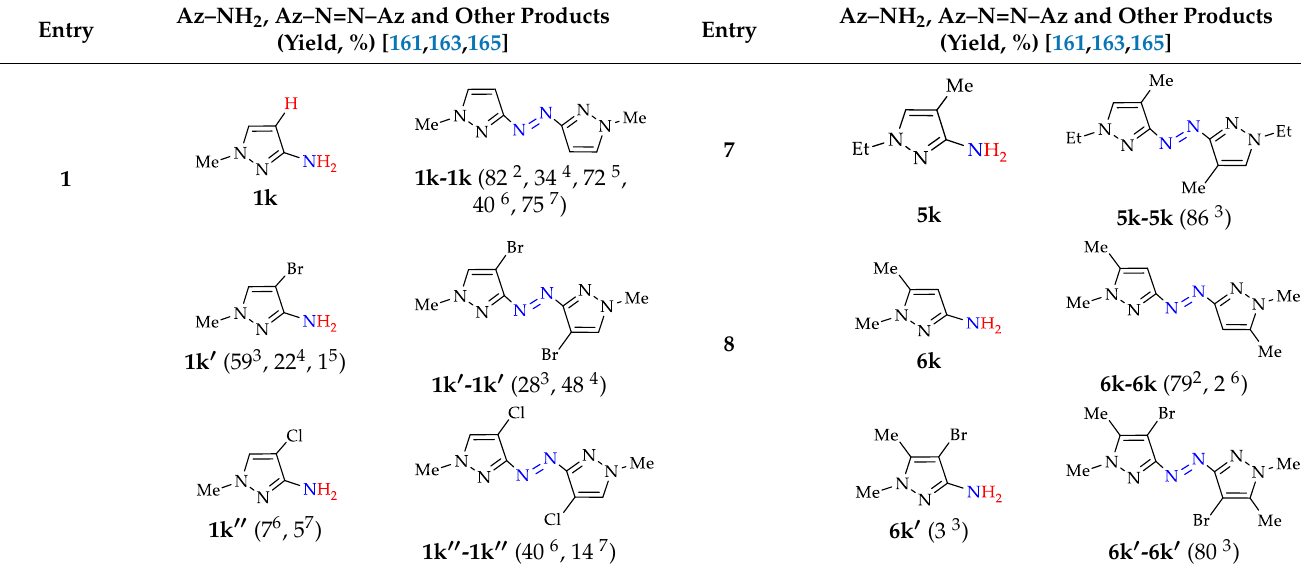
Table 6. N – N homo-coupling of aminopyrazoles (Az – NH 2 ) using approaches A, B, C (C ’ ), D (D ’ ) 1 . Entry Az – NH 2, Az – N=N – Az and other Products (Yield, %)